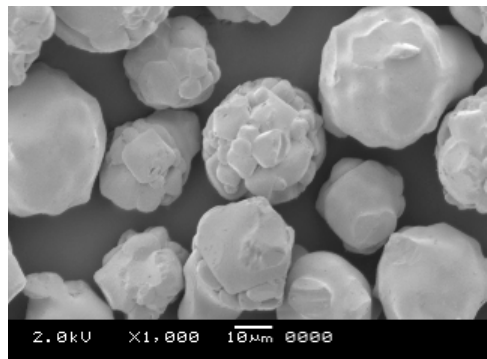
Figure 1. Scanning electron micrograph of the micro-sized ferrite particles (average diameter = 35 µ m, true density = 4.89 g/cm 3 ).